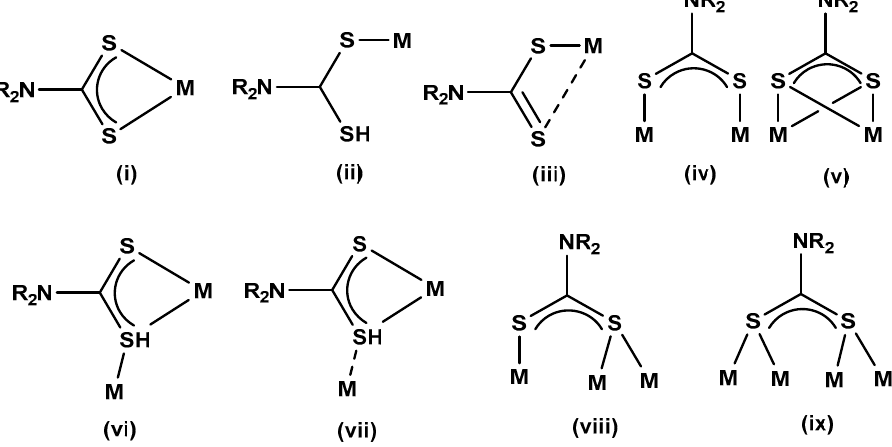
Figure 2. Nine possible coordination modes of dithiocarbamate [15].